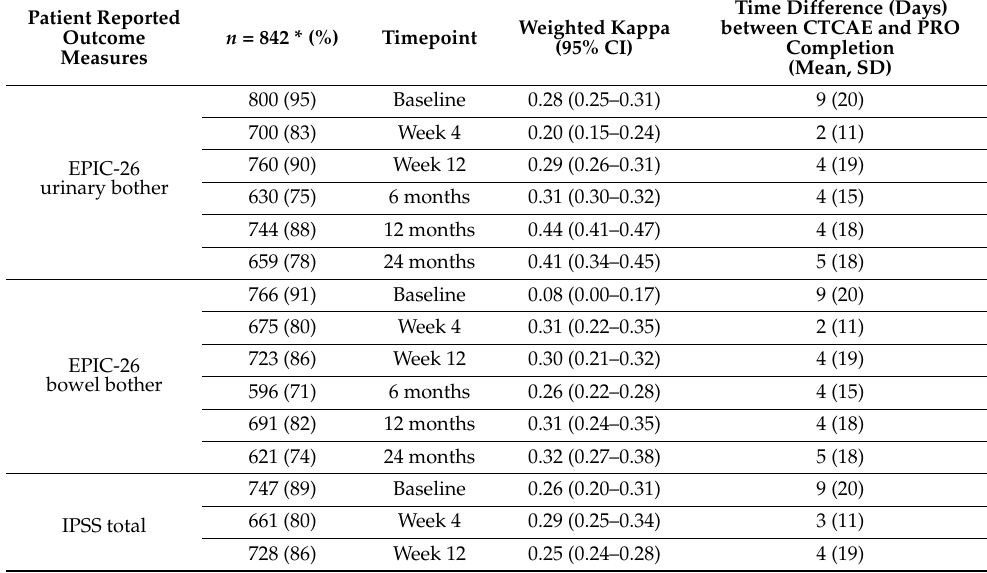
Table 6. Weight kappa statistic demonstrating agreement between CTCAE and patient reported outcome measures (EPIC-26 and IPSS) is different